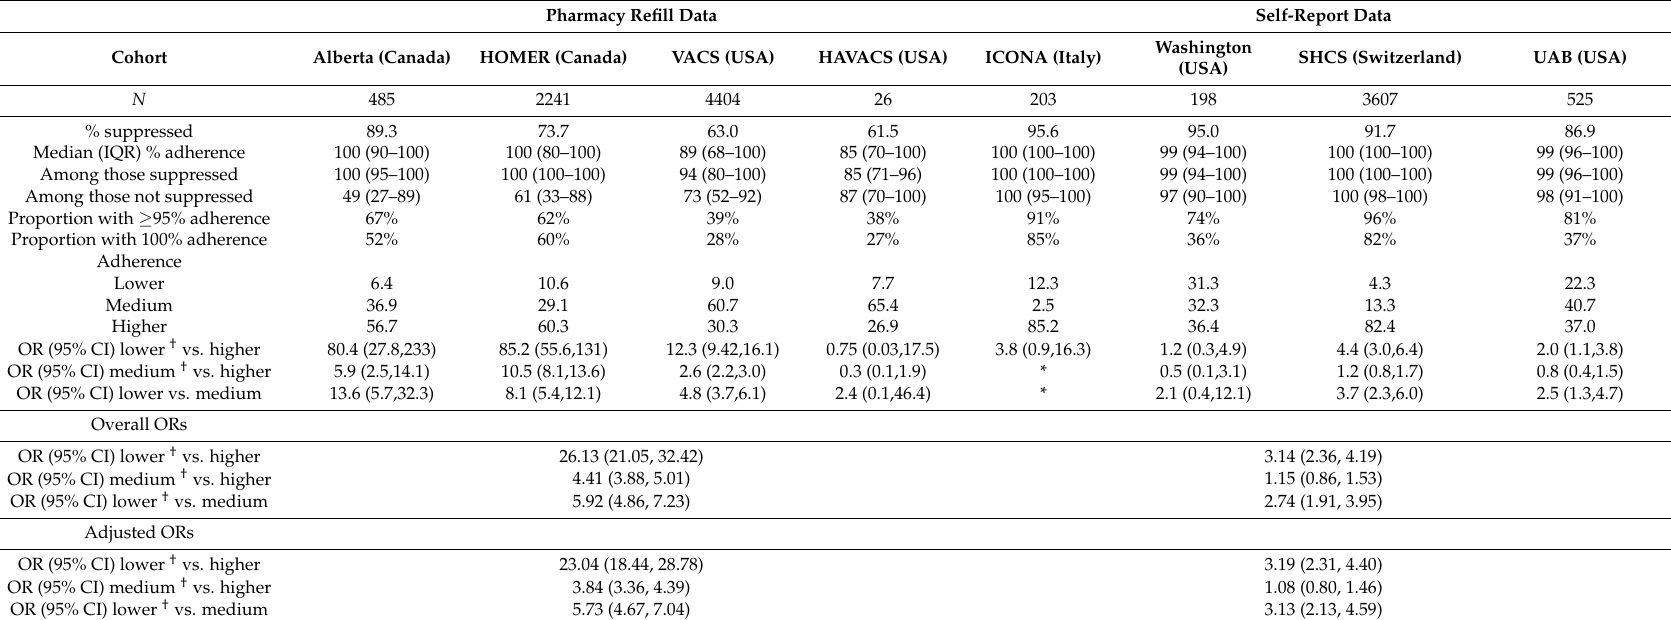
Table 2. Viral suppression and levels of adherence across cohorts. Odds ratios (OR) and 95% CI for associations of adherence with viral failure. Pharmacy Refill